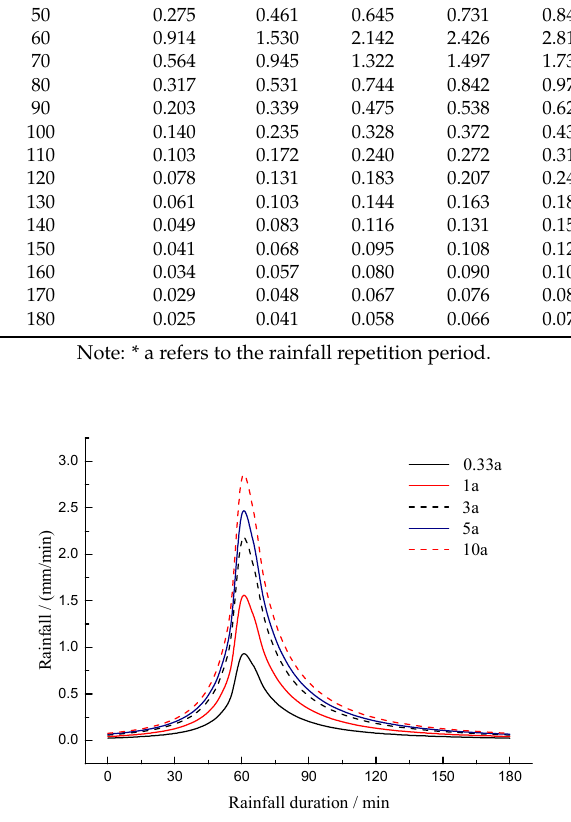
Figure 5. Rainfall hydrograph of various repeating rainfall periods when the rainfall peak coefficient is is 0.34.